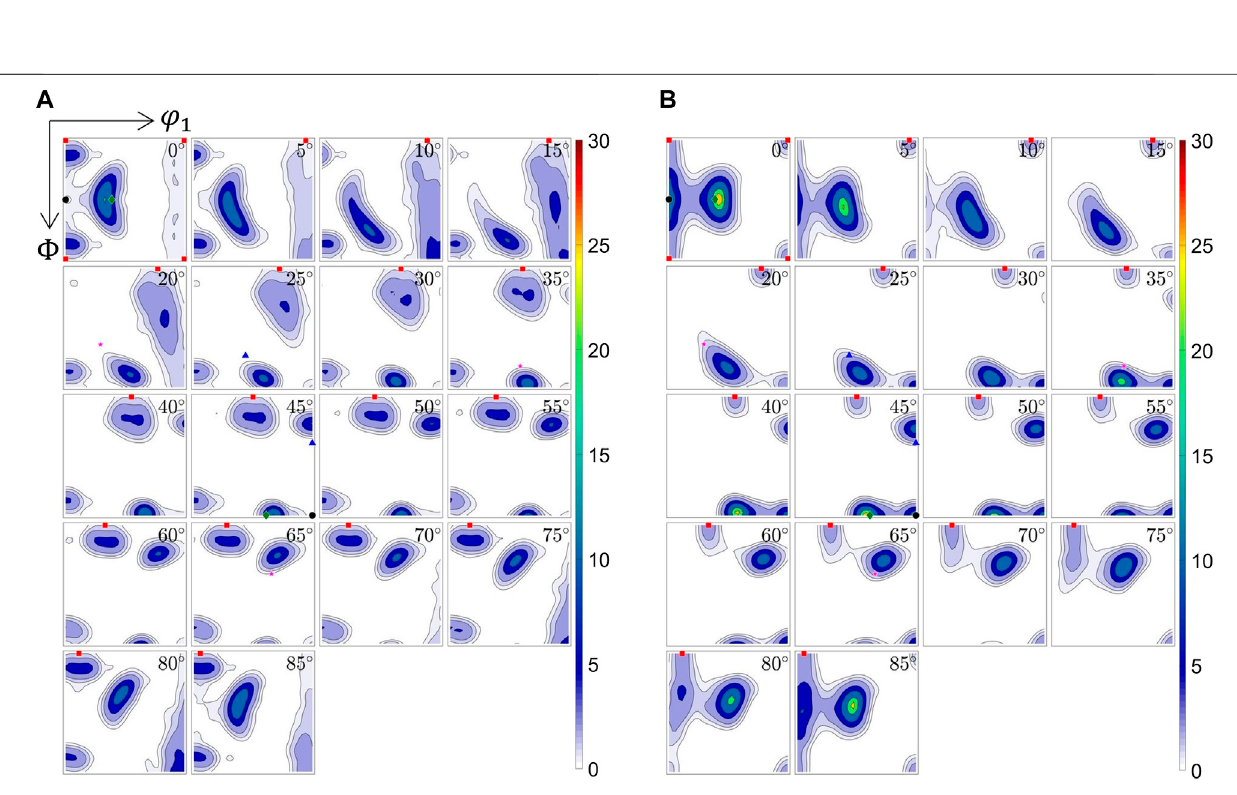
Frontiers in Materials |